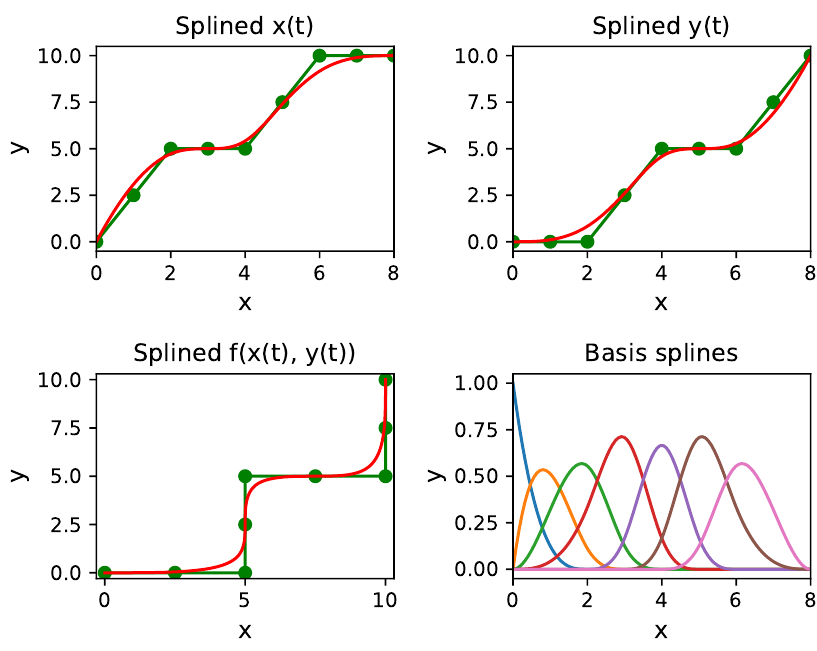
Figure 4. An example of path smoothing using B-Spline. The green path is the global path while the red path is the smooth path. The green dots are the control